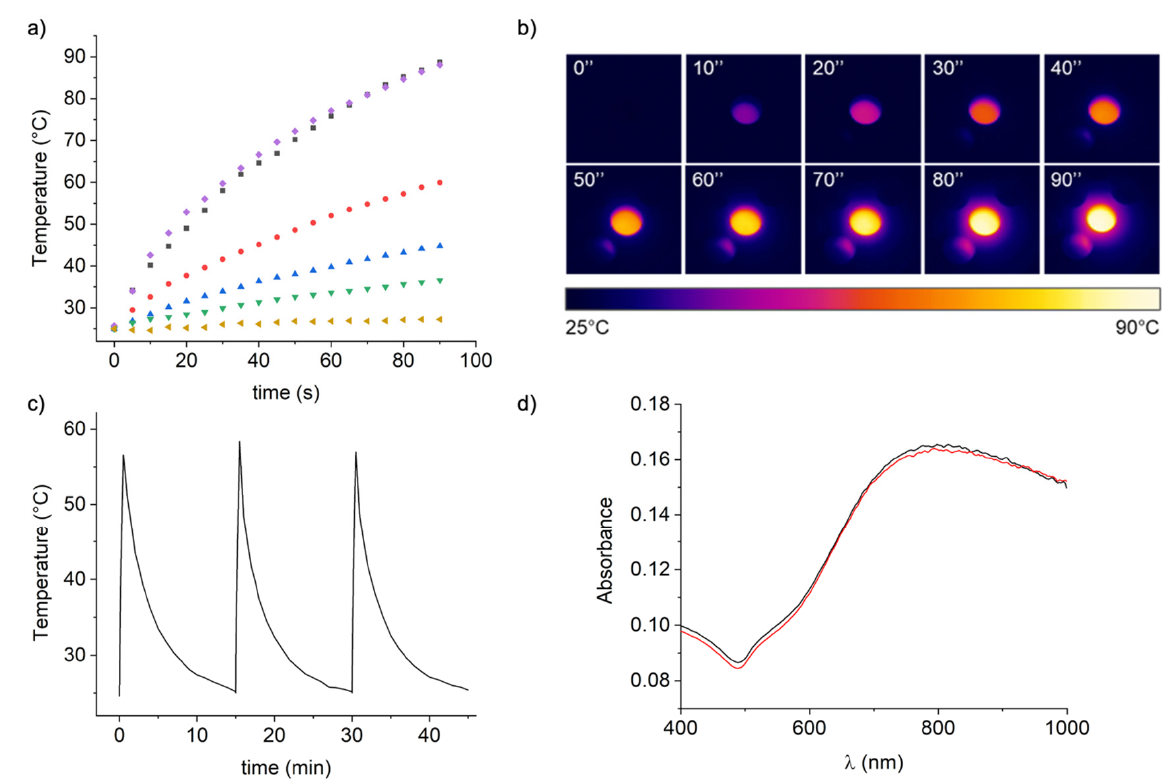
Figure 2. The photothermal effect of BGNPs in a phantom system. ( a ) Heating curves for different concentrations of BGNPs in water (0.25 mM Au 0 in violet, 0.1 mM Au 0 in red, 0.05 mM Au 0 in blue, 0.025 mM Au 0 in green, H 2 O in yellow) and the BGNP biomolecular corona in water (0.25 mM Au 0 in black) during 808 nm NIR laser irradiation (6.6 W cm − 2 ). ( b ) Thermal imaging of the solution containing BGNPs (0.25 mM Au 0 ) for different times. ( c ) Temperature change of the solution containing BGNPs (0.25 mM Au 0 ), showing three laser on/off cycles of 808 NIR laser (6.6 W cm − 2 ). The sample was heated for 30 s, then the laser was switched off for 15 min and the solution was left to cool. ( d ) Vis–NIR spectra of the BGNPs before (black) and after (red) laser irradiation/heating.